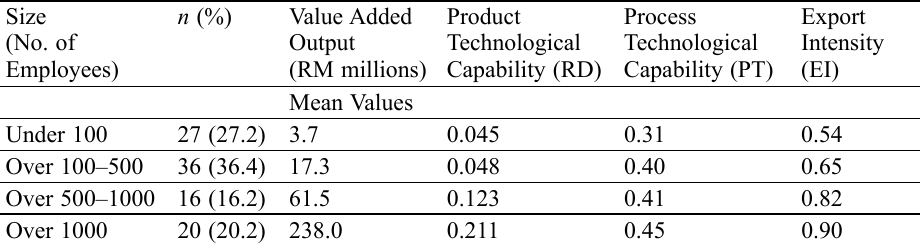
Table 1. Sample profile by size and mean values,